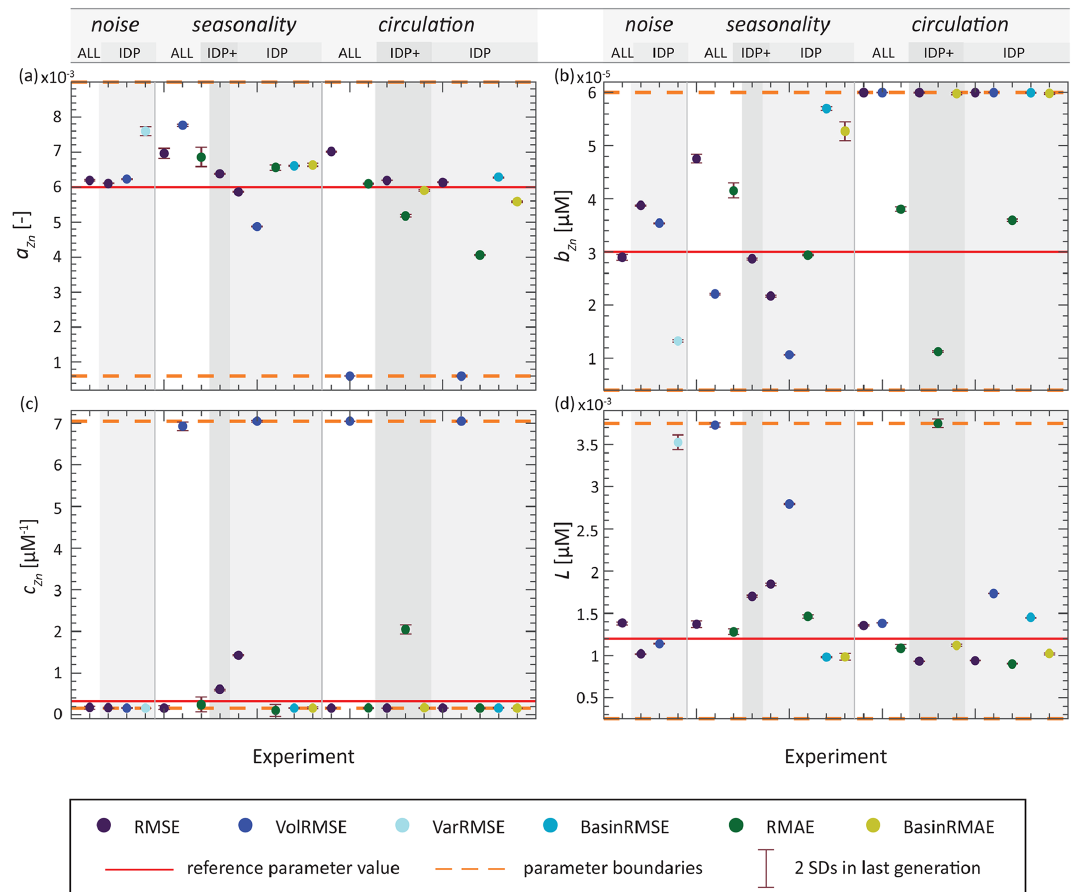
Figure 5. Results from the last generation of all synObs experiments. Error bars represent 2 standard deviations calculated using the 10 indi- viduals of the last generation. Dots represent parameter values resulting in minimum misfit within the prescribed boundaries during optimi- sation, coloured according to misfit